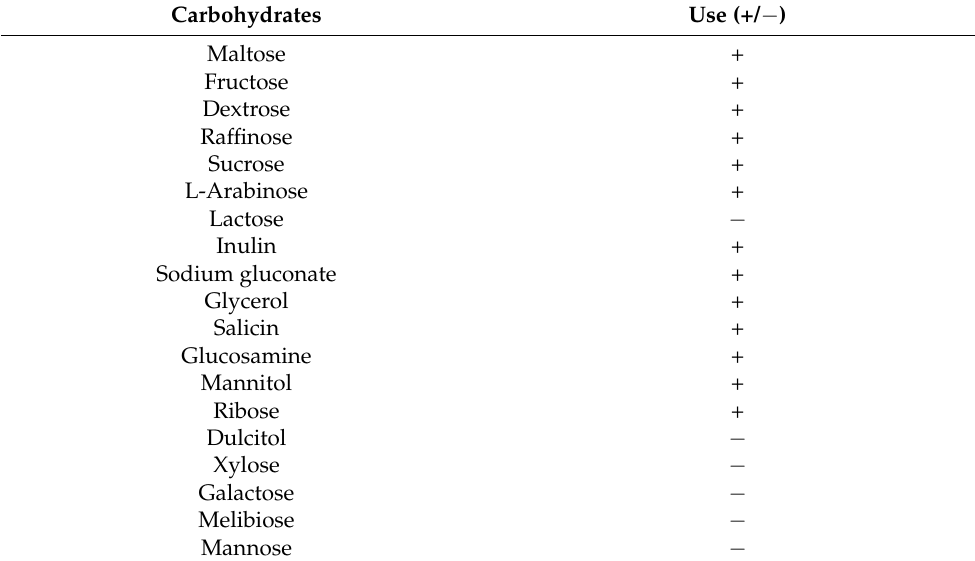
Table 1. Biochemical characterization of selected screened isolate B. subtilis D3L/1.